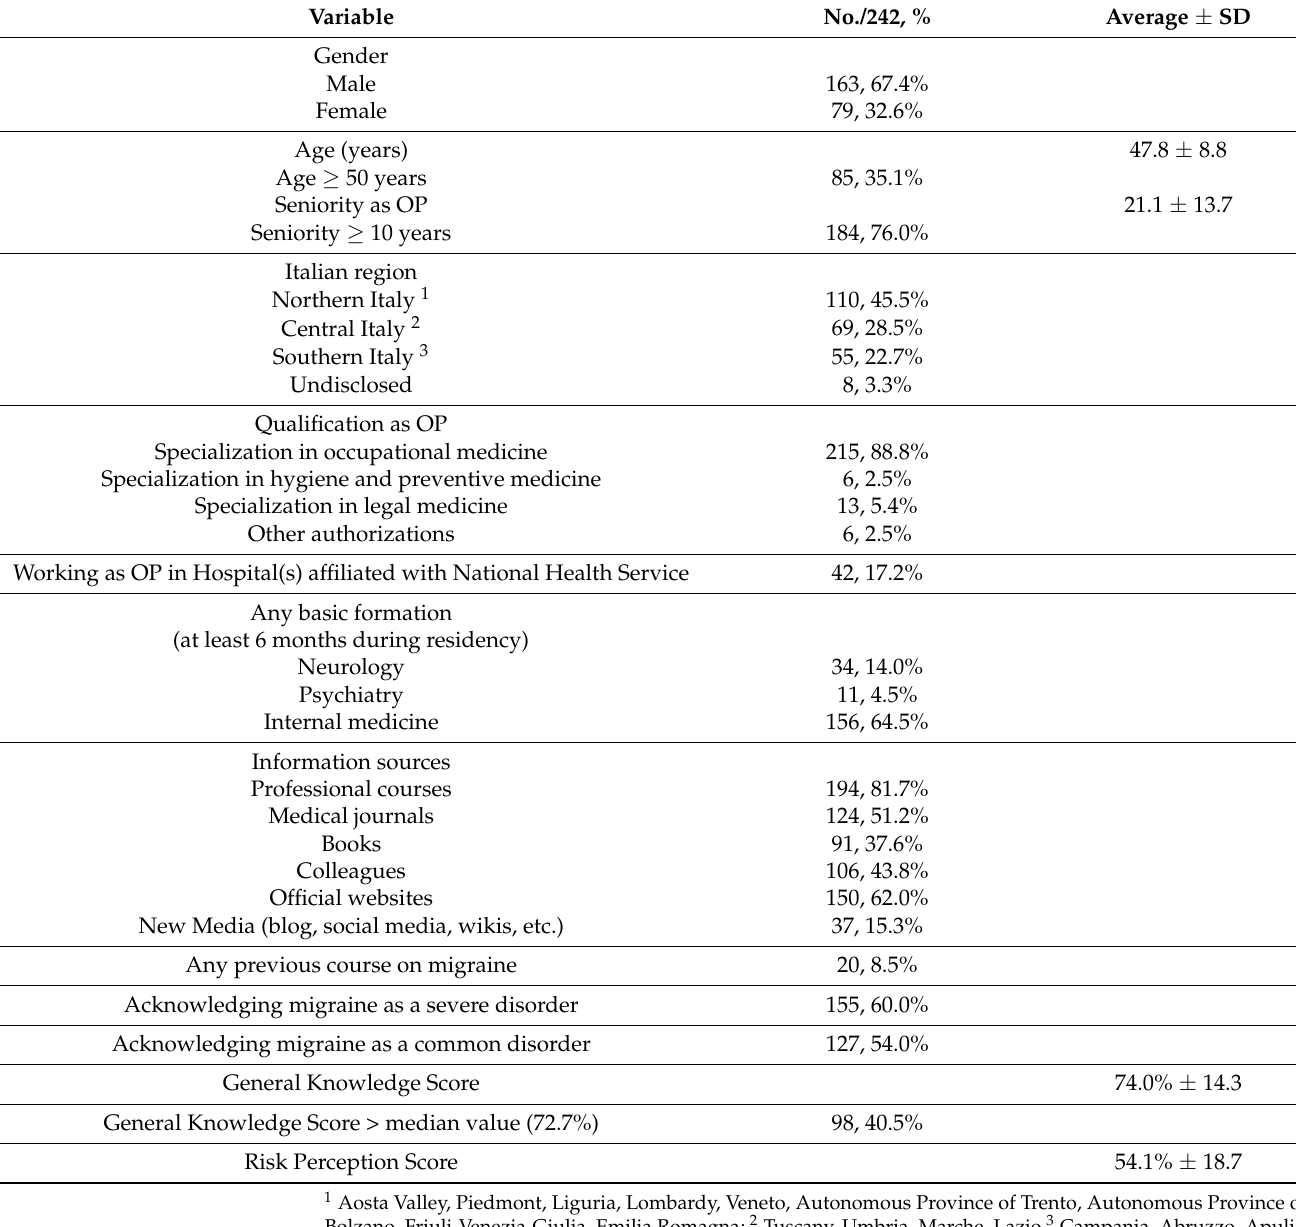
Table 1. Characteristics of the 242 Italian occupational physicians (OP) participating into the survey on knowledge, attitudes and practices on migraine in the